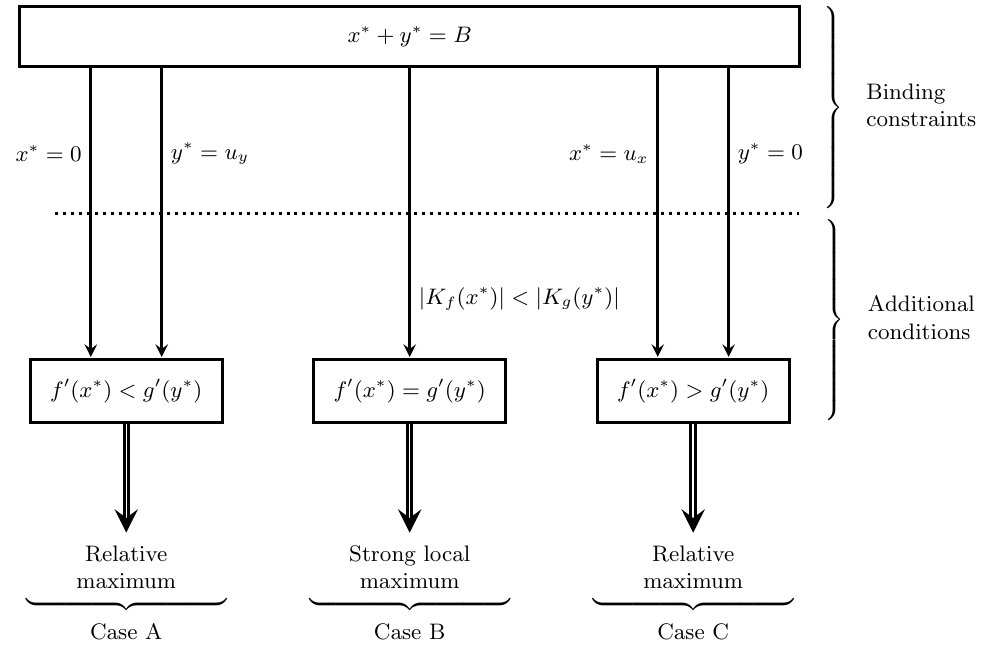
Figure 1: Schematic representation of the cases in Theorem